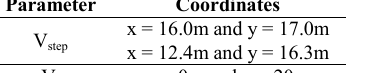
TABLE IV C OORDINATE MAXIMUM OF THE SURFACE POTENTIAL AND STEP VOLTAGE .